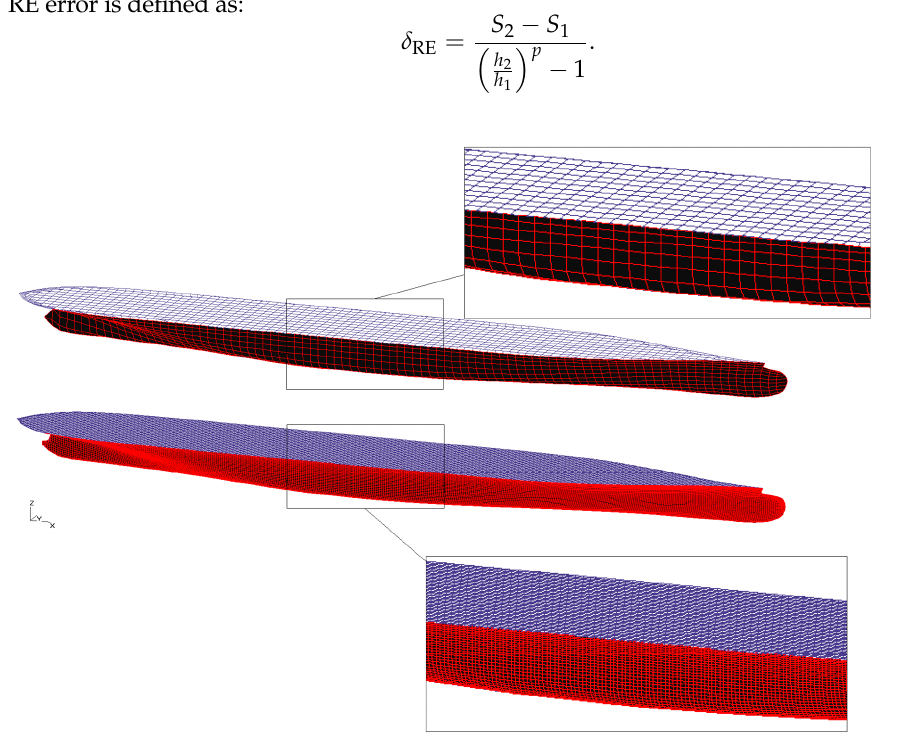
Figure 2. Coarse ( upper ) and fine panel model ( lower ) of KCS.